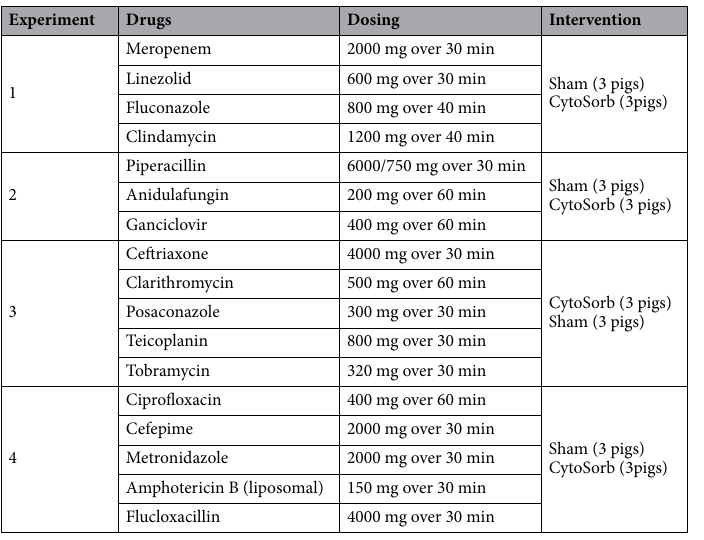
Table 1. Experimental groups. Pigs received different combinations of drugs, followed by initiation of an extra-corporeal circulation with (cases) or without (sham, control) a CytoSorb cartridge. Three animals were randomly allocated to each group. All drugs were administered intravenously one hour before extra-corporeal circulation initiation.